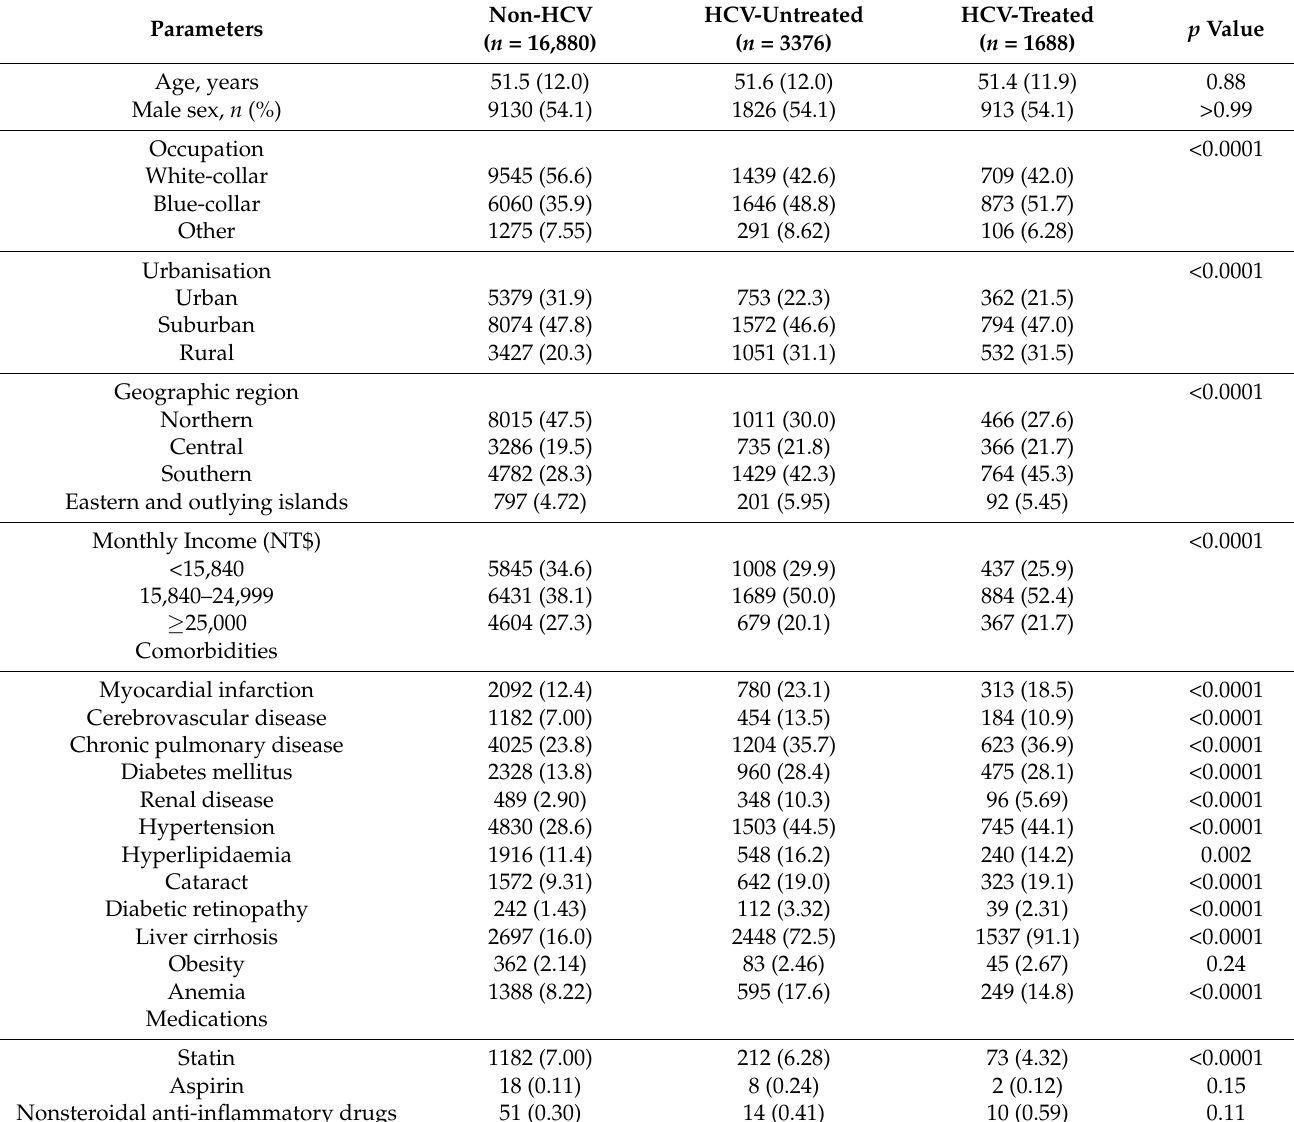
Table 1. Sociodemographic characteristics and comorbidities of the non-hepatitis C virus (HCV), HCV-untreated, and HCV-treated